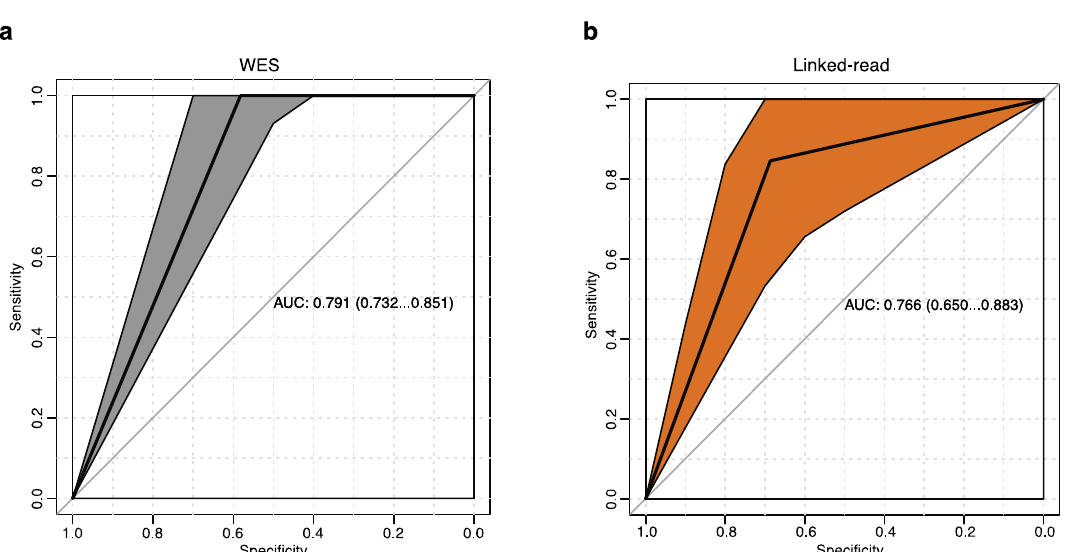
Figure 4. Receiver operating characteristics (ROC) analysis. ( a , b ) ROC curves of FISH-detected clinically relevant cytogenetics events compared with both linked-read and WES. The area under the curve (AUC) and confidence intervals are shown in the figures. The WES method provided higher AUC values. The x -axis represents specificity, and the y -axis represents sensitivity. ( a ) WES shows an AUC of 0.791 ( b ) Linked-read shows an AUC of 0.766.